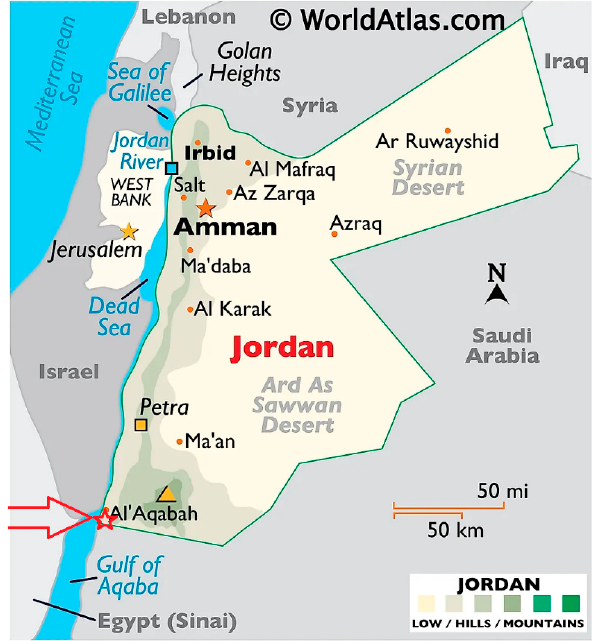
Figure 3. The proposed selected site for installing the hydrogen power plant [26], the red arrow signs to Aqaba (the selected site).